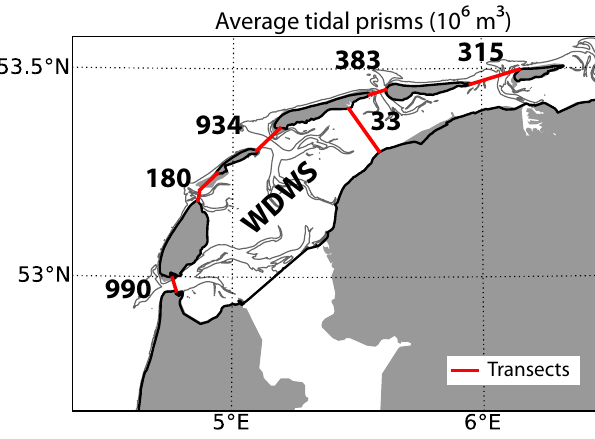
Figure 10. Average tidal prisms (10 6 m 3 ) of each inlet and the Ter- schelling watershed. The red lines mark the position of the transects used to compute the tidal prisms and transport. The numbers repre- sent the tidal prism in 10 6 m 3